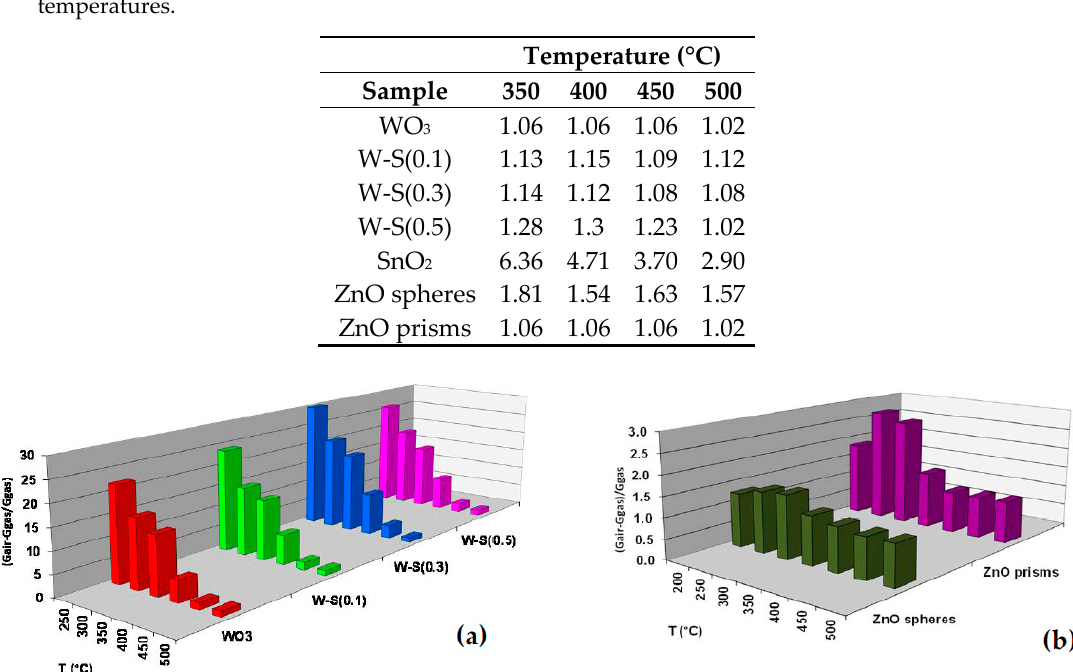
Figure 5. ( a ) Responses of W-Sn sensors to 1 ppm of NO 2 reported as (G air -G gas )/G gas obtained at different working temperatures; ( b ) responses to 100 ppb of O 3 for ZnO spheres and prisms both fired at 650